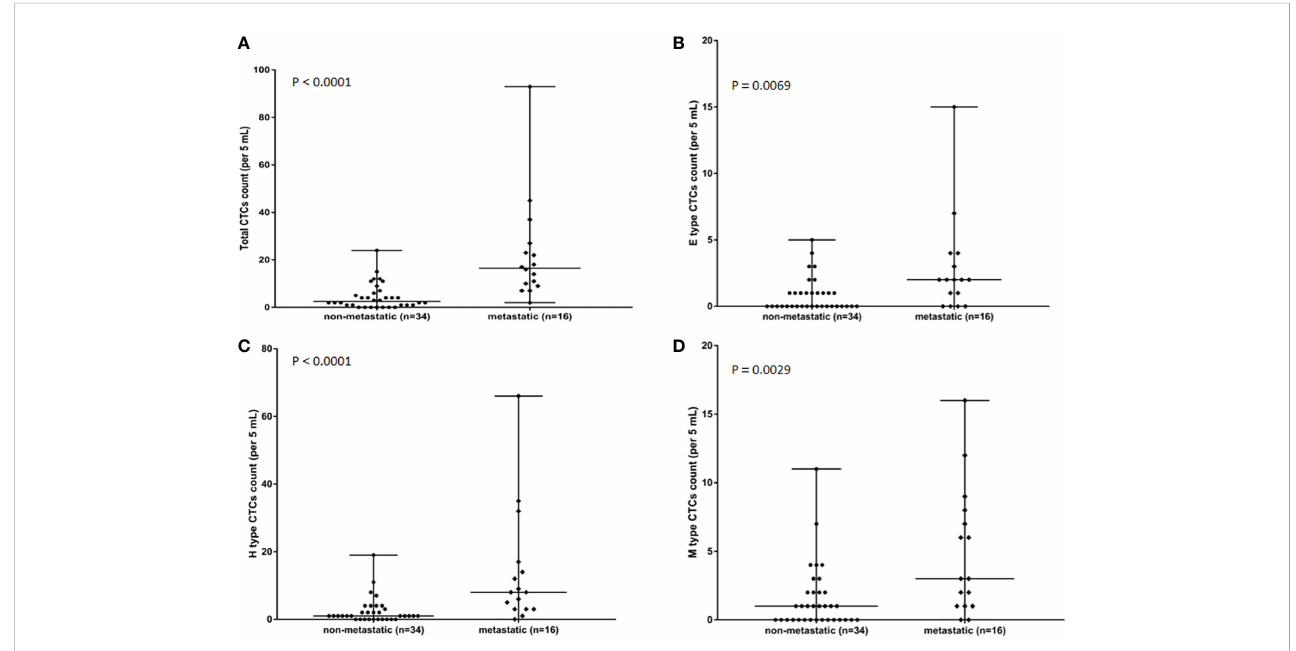
FIGURE 3 Associations in total CTC number (A) , E-type CTC number (B) , H-type CTCs number (C) , and M-type CTCs numbers (D) in metastatic osteosarcoma patients ( n = 16) and non-metastatic osteosarcoma ( n = 34) patients. P value was analyzed with Mann-Whitney U test. Each experiment was repeated for three times, and each group had four